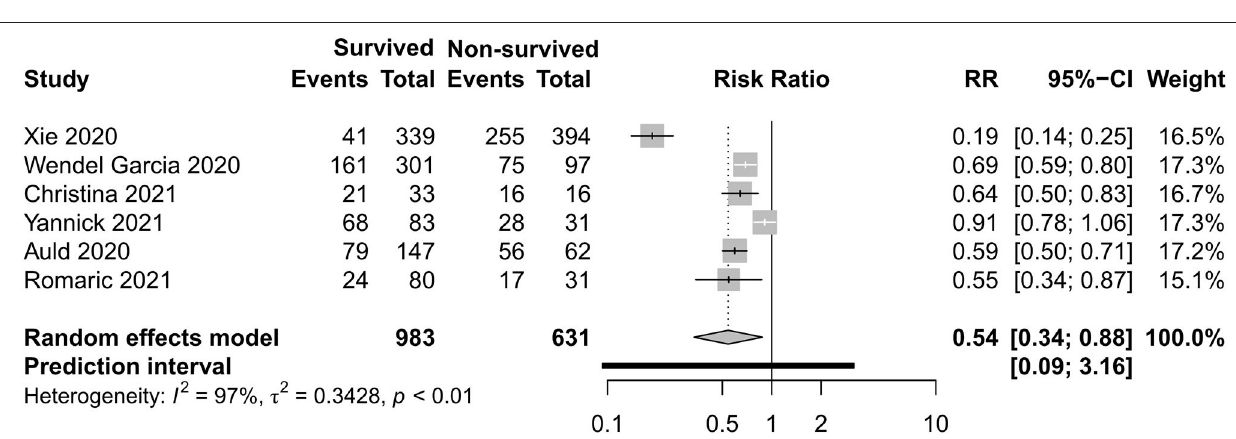
FIGURE 13 | Risk ratio of vasopressors between survived and non-survived